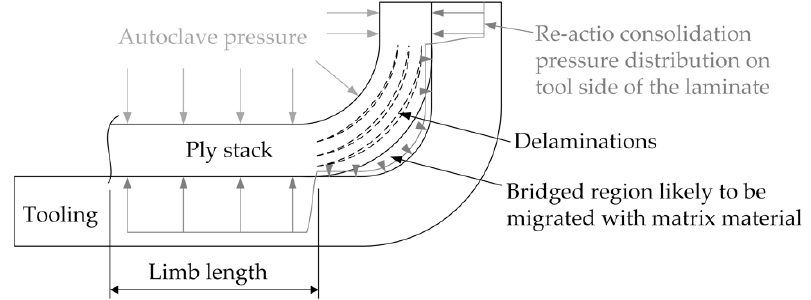
Figure 15. Ply bridging in internal corner radius leading to matrix migration.